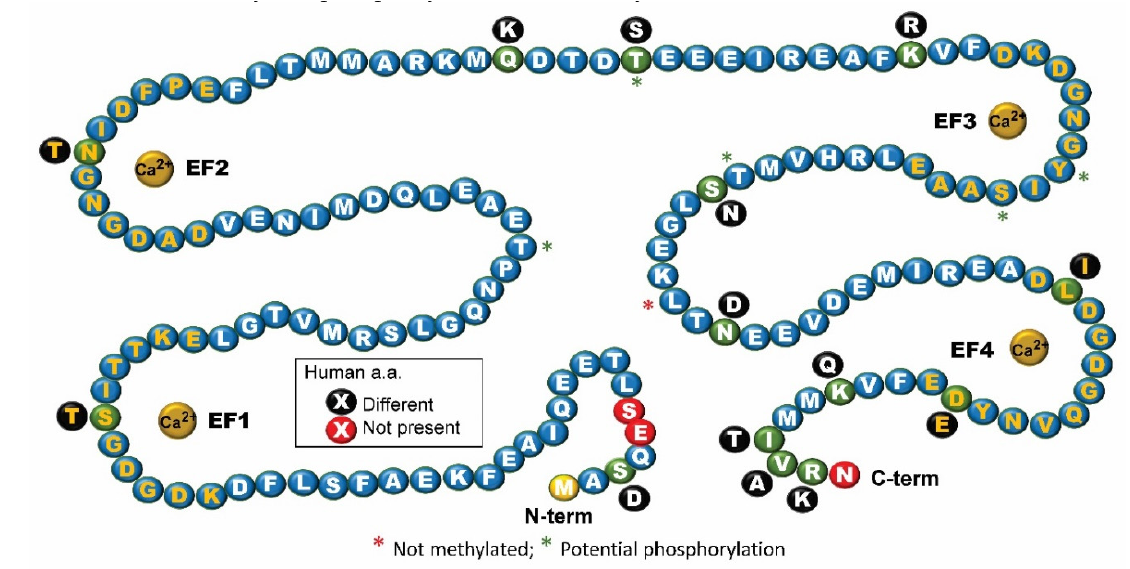
Figure 1. The sequence of Dictyostelium calmodulin (CalA) noting the differences from human calmodulin (CaM). Black circles, adjacent to the green circles in CalA, indicate amino acid differences in human CaM. Red circles show amino acids that are not present in human CaM. EF hand (EF-1 to -4) amino acids are shown in gold text. Note: the initiator methionine shown here is removed from functional CalA. Graphic modeled designed after Figure 1 in [19].